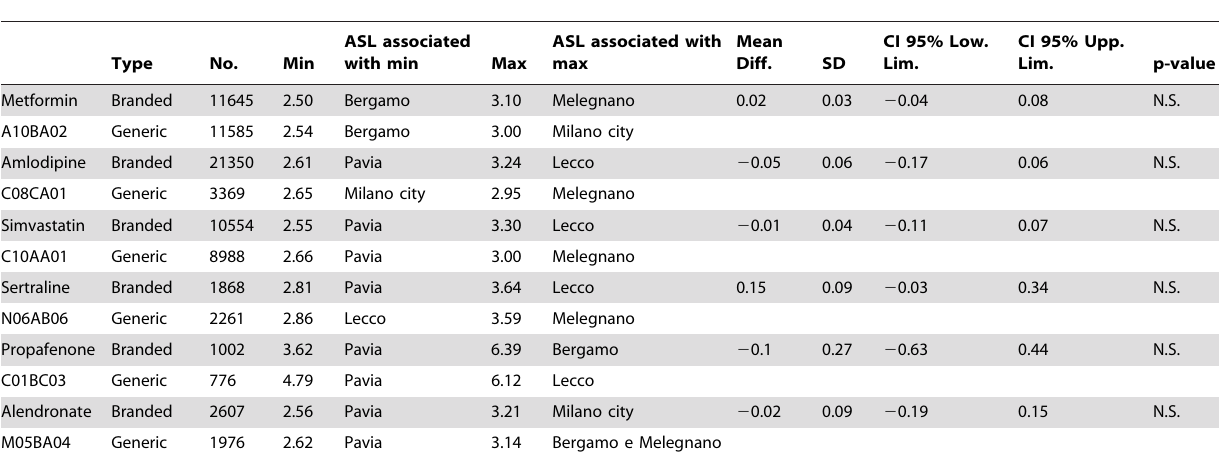
Table 5. Specialist examinations in persistent patients (mean number of specialist